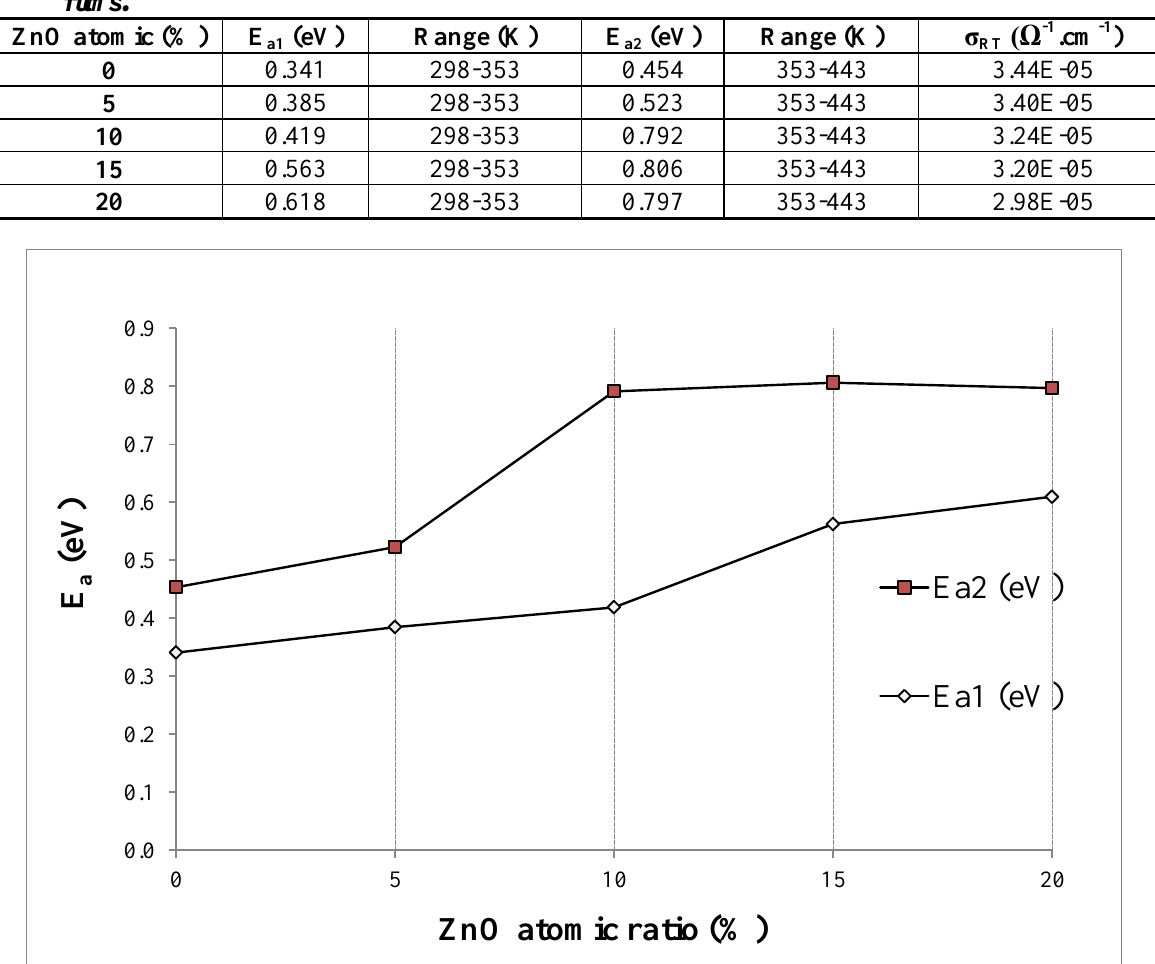
Fig.3: Variation of activation energies with ZnO atomic ratio in prepared